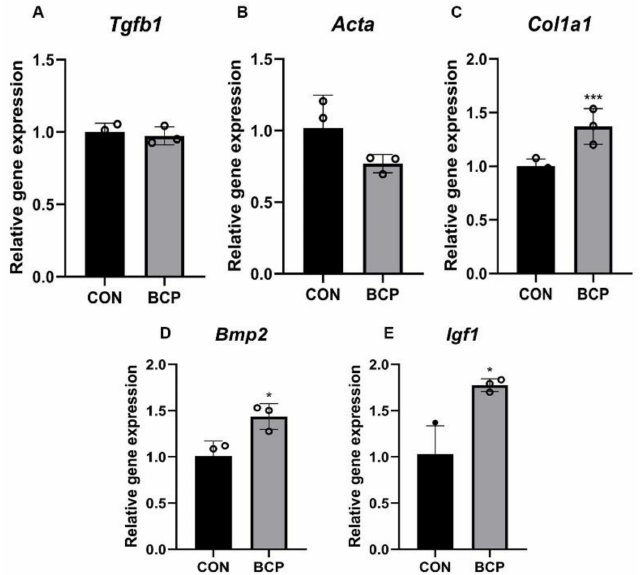
Figure 8. Gene expression of L929 fibroblasts induced by BCP ceramics. ( A – C ) Tgfb 1, Acta , Col1a1 ; and ( D , E ) Bmp2 and Igf1 expression in fibroblasts treated by BCP ceramics were evaluated by qRT-PCR. Relative gene expression was normalized by Gapdh . *** indicated p < 0.001; * indicated p <